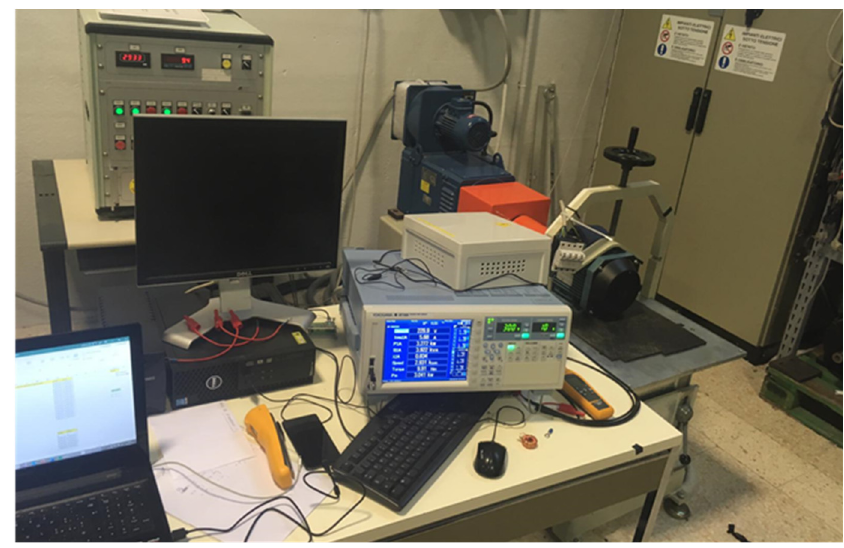
Figure 11. The measurement setup.